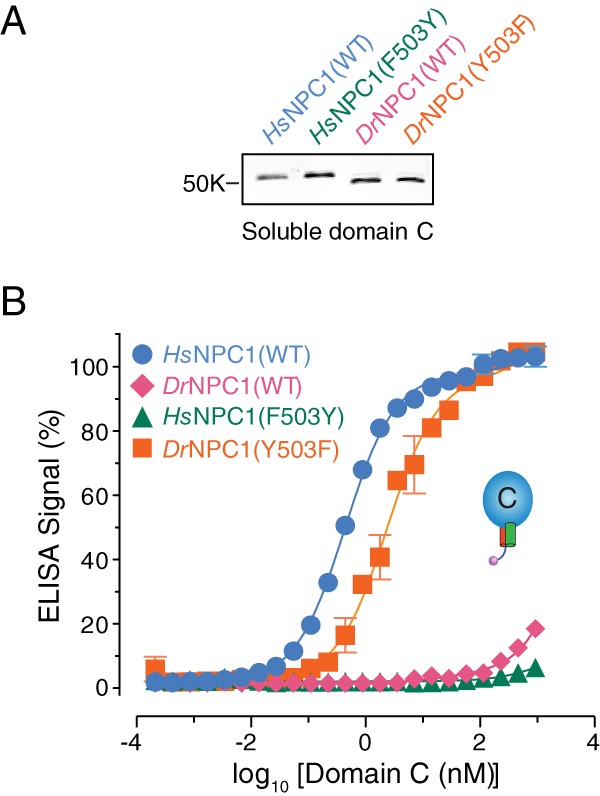
NPC1 residue 503 bidirectionally alters domain C’s capacity to bind EBOV GPCL. (A) HsNPC1 and DrNPC1 domain C proteins bearing point mutations at residue 503 (HsNPC1, F503Y; DrNPC1, Y503F) were expressed and purified. (B) Serial dilutions of equivalent amounts of purified NPC1 domain C proteins were tested for EBOV GPCL binding by ELISA.